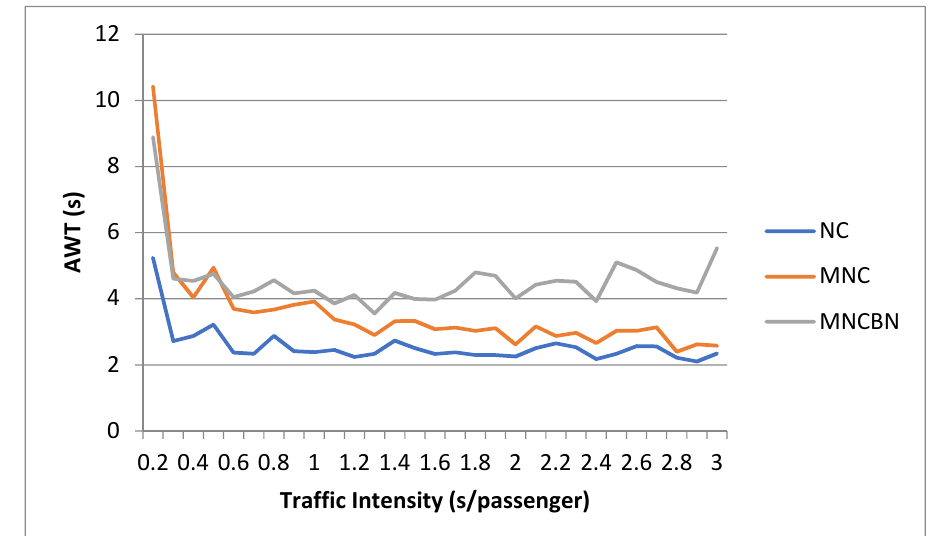
Figure 10. Dependence of AWT on change in traffic intensity.